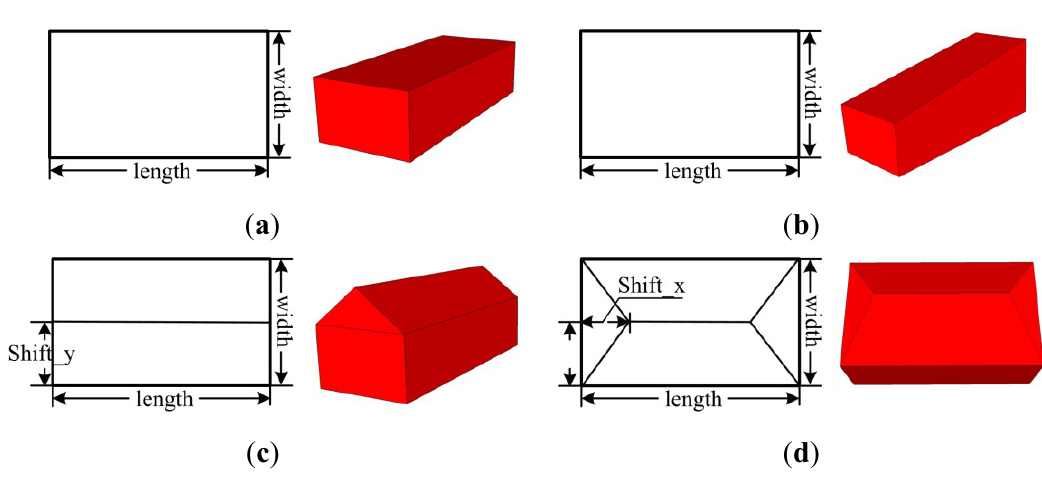
Figure 2. Basic roof primitives and their shape parameters. ( a ) Flat roof; ( b ) Shed roof; ( c ) Gabled roof; ( d ) Hipped roof; ( e ) A complex flat